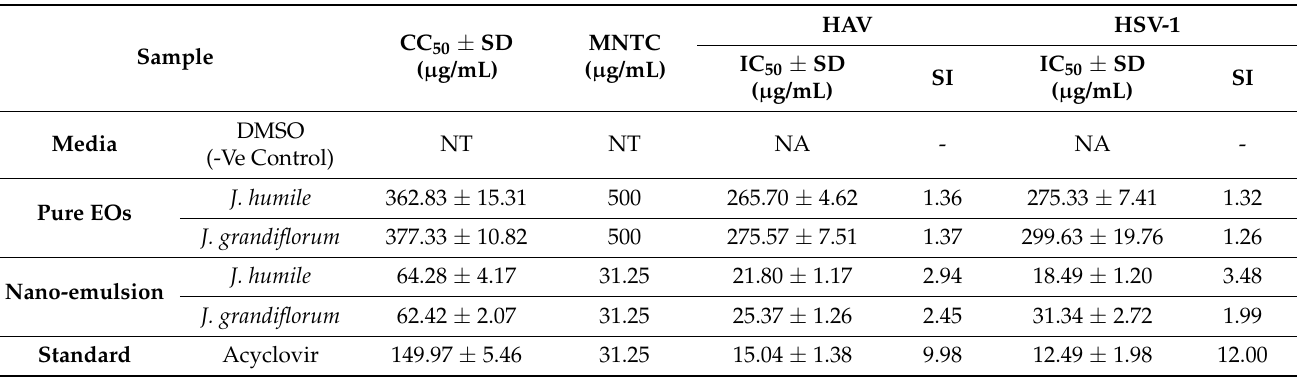
Table 3. Results of the antiviral assay of the nanoemulsion formulations of the essential oils ob- tained from Jasminum humile L. (JhEO-NE) and Jasminum grandiflorum L. (JgEO-NE) as well as the reference drug acyclovir showing CC 50 , MNTC, IC 50 , and selectivity indices (SI) against HAV and HSV-I